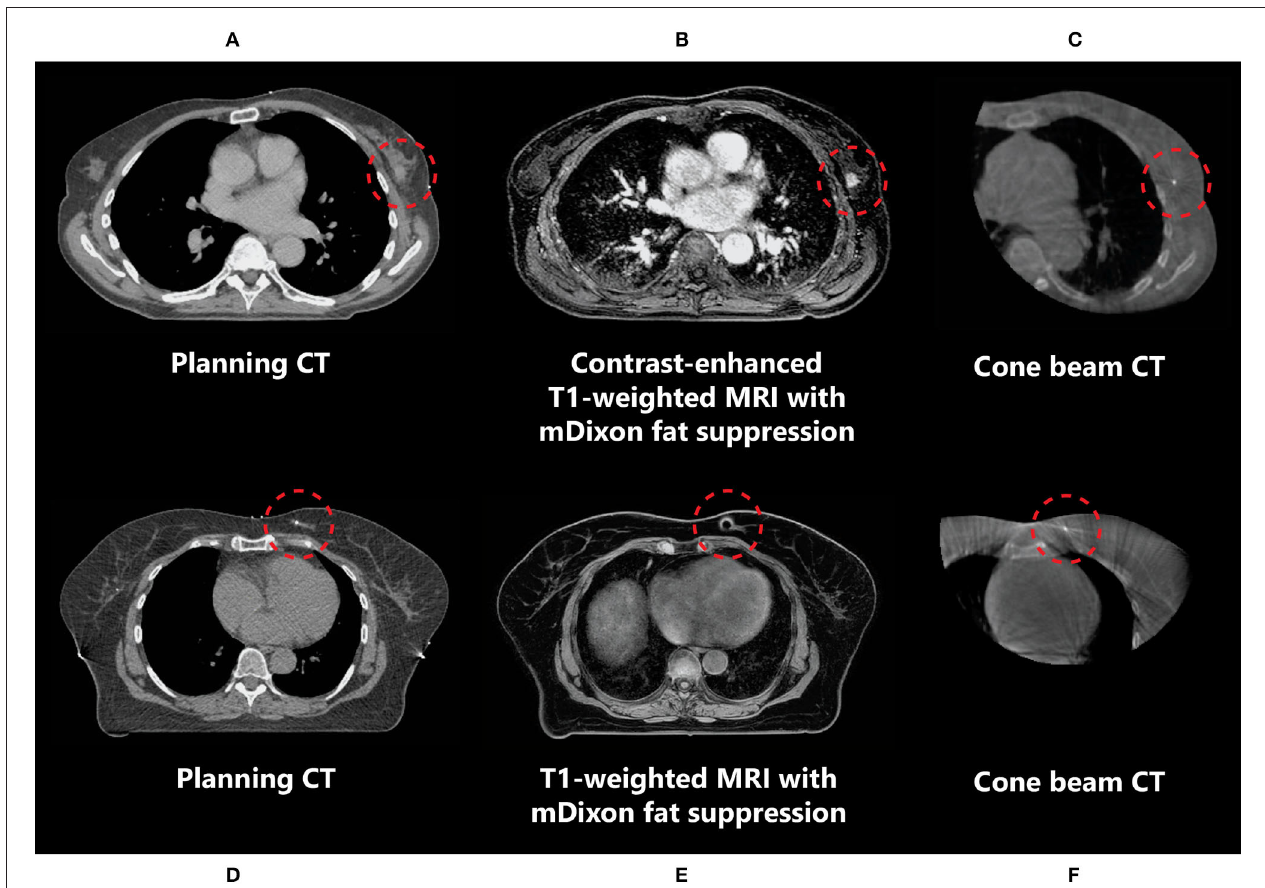
FIGURE 3 | Imaging of a primary breast tumour on CT (A,D) , (contrast-enhanced) MRI (B,E) , and CBCT (C,F) scans indicating the difference in tumour visibility (inside the red circle) between these modalities in two different patients ( A–C and D–F ). (D–F) The marker inserted in the tumour medial in the left breast is observed as a void on MRI (indicated by the red